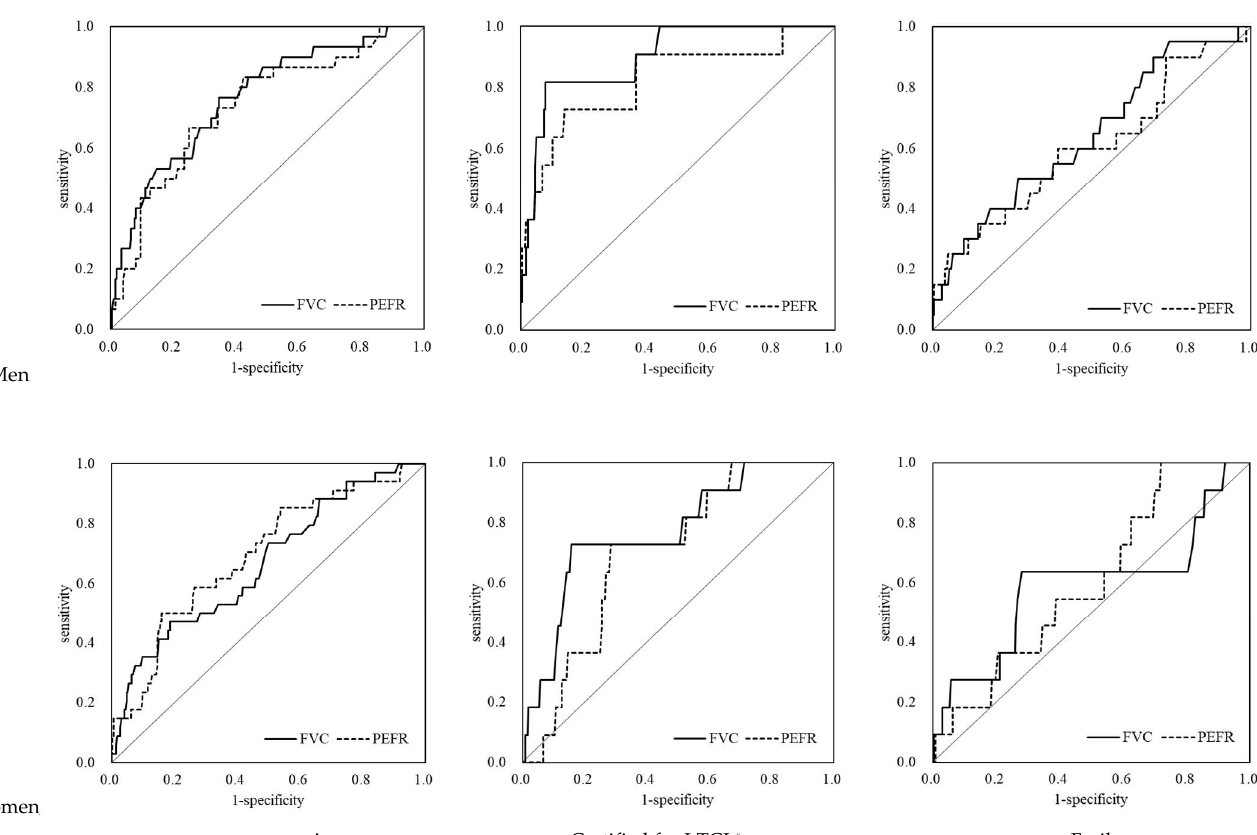
Figure 2. ROC analysis of FVC and PEFR for criterion variables. # Support levels 1 or 2 and long-term care levels 1–5 on LTCI. FVC: forced vital capacity; PEFR: peak expiratory flow rate; LTCI: long-term care insurance certification.